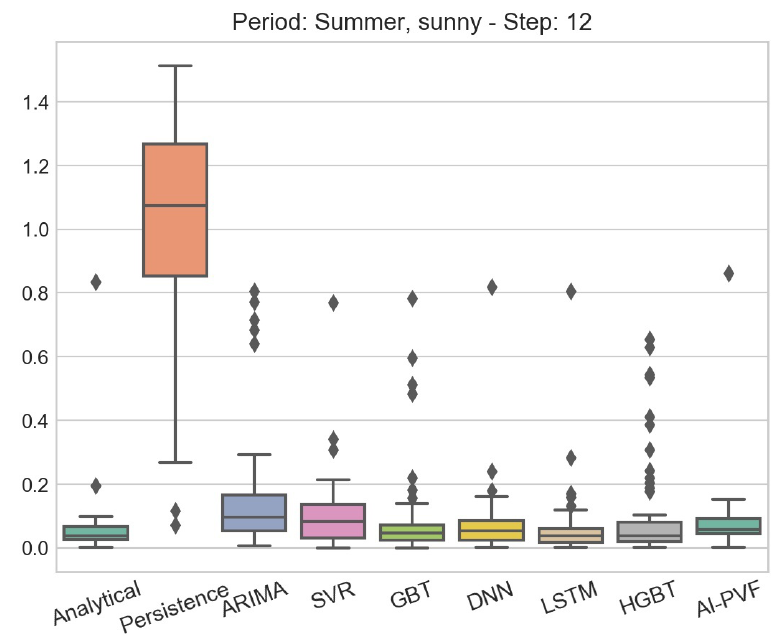
Figure 6. Boxplot of residuals for all PV power generation forecasting models. The data partition examined in this case is the sunny days subperiod of the summer season and the forecasting horizon is 12 steps